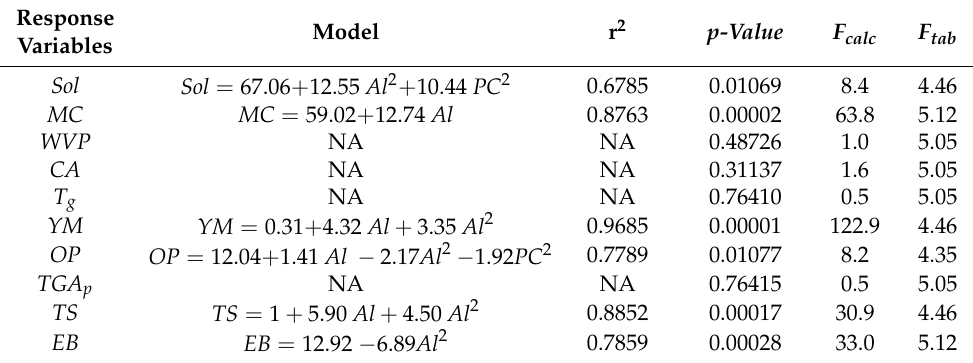
Table 5. Central Composite Rotatable Design (CCRD) results ( F calc and F tab represent the calculated and tabulated F distribution at a 5% significance,